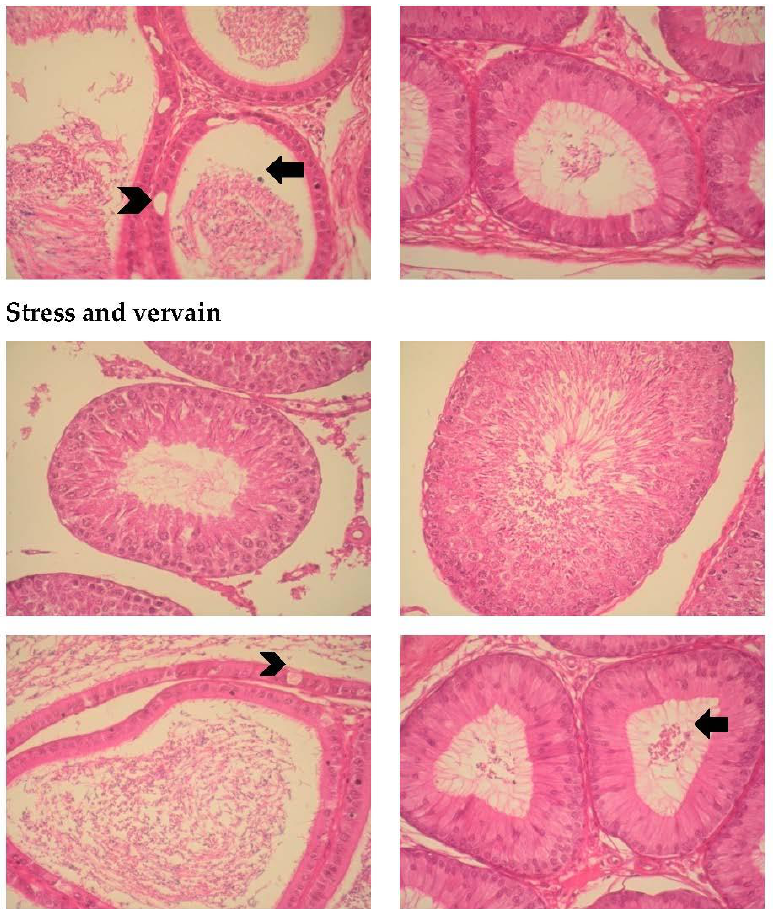
Figure 11. Analysis of histopathologic changes in the testis and epididymis, H.E. staining, 400×. The first images are representative of the negative controls with animals kept under normal conditions. Histological changes were observed in the testis and epididymis of treatment groups. These changes include immature cells ( arrow ) in the lumen of the seminiferous tubules and epididymis and vacuoles ( arrowhead ) in the pseudostratified columnar epithelium of the epididymis.